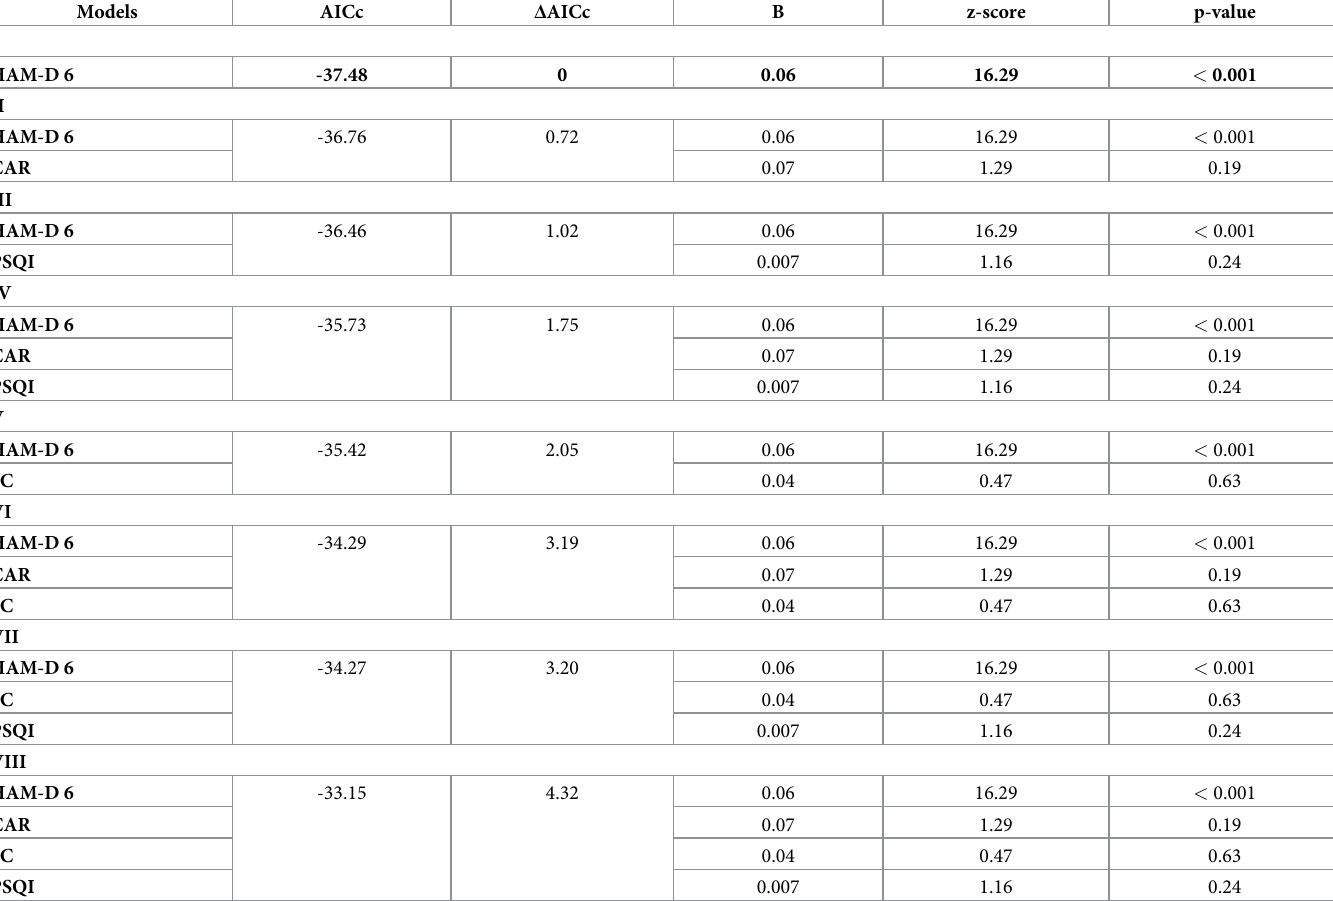
Table 1. Regression models for major depression disorder diagnosis, possible predictive models of discrimination between patients in first depressive episode (MD: n = 30) and the healthy controls (CG: n = 32). Models AICc Δ AICc Β z-score p-value -37.48